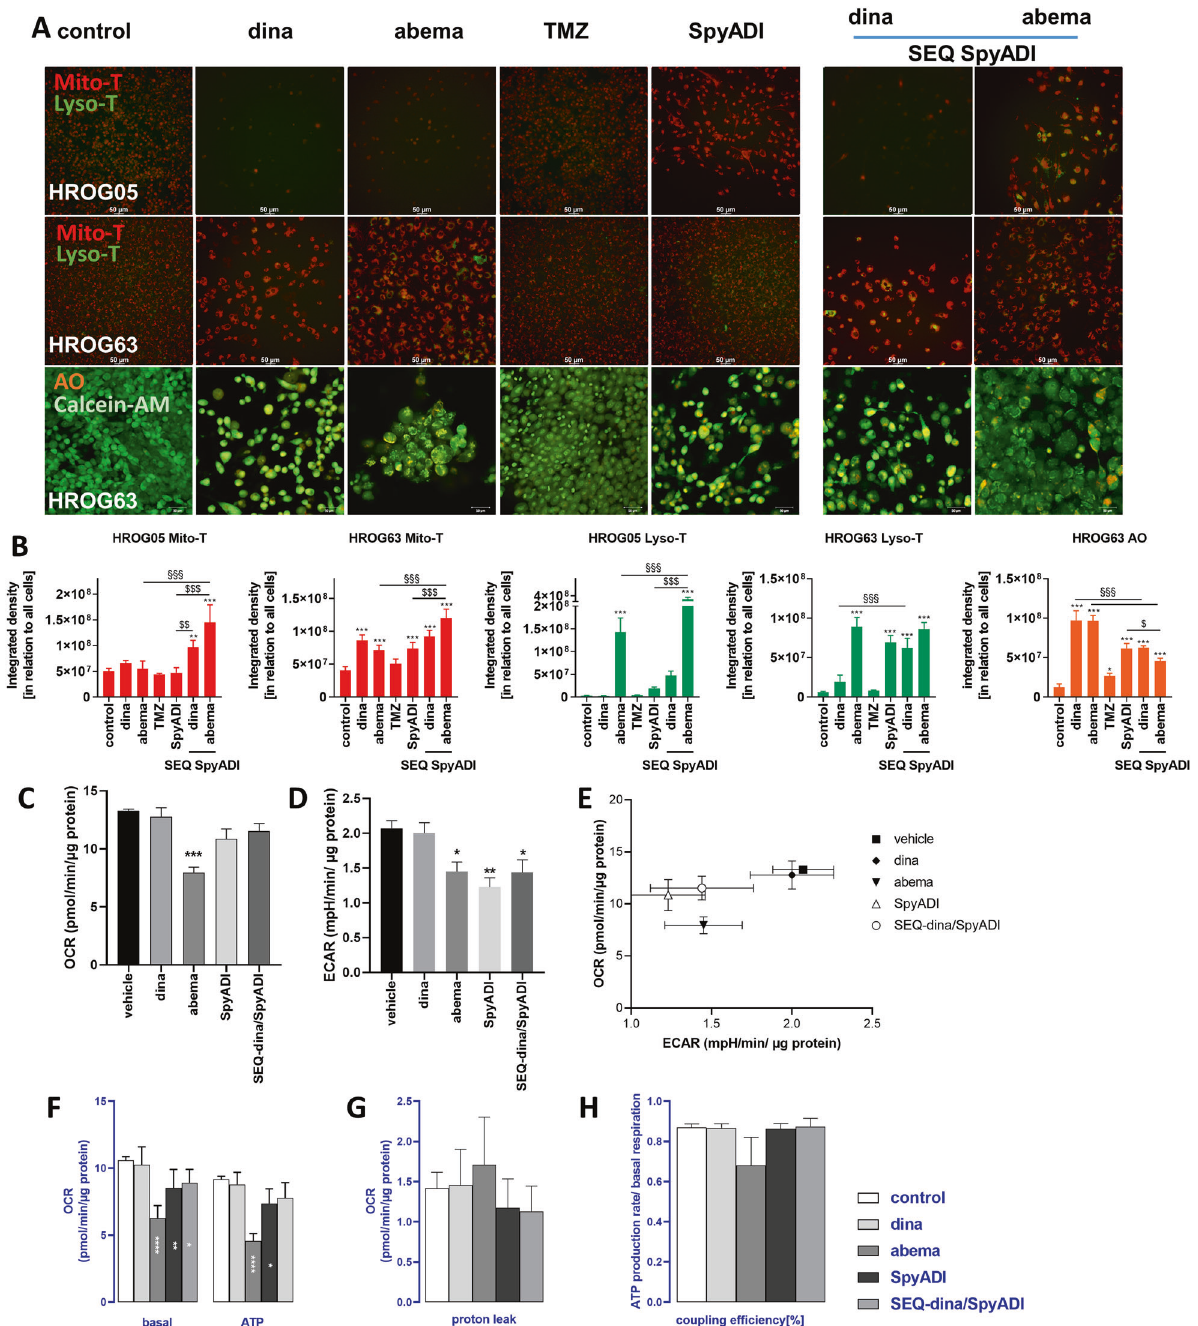
Fig. 4 In fl uence on mitochondria, lysosomes/autophagy, ER and extracellular fl ux analysis. A , B Mitochondrial function and/or acidic compartments (LysoTracker and Acridine orange (AO)) in 2D-cultured and treated GBM cells (HROG05, HROG63) was examined by immuno fl uorescence imaging as described in materials and methods (Mito- [red] and Lyso-Tracker [green]; Calcein AM [green] and Acridine orange [orange]). A Merged fl uorescence is presented (scale bar A : 50 μ m). CDKi-SpyADI impairs mitochondrial membrane potential (MMP) and SEQ-abemaciclib administration elevates LysoTracker and AO staining. B Quanti fi cation of Mito- and Lyso-Tracker as well as AO-positive cells using ImageJ software (integrated density analysis). n = 3 – 6 independent experiments; ** p < 0.01; *** p < 0.001; §§§ p < 0.001; $ p < 0.05; $$ p < 0.01; $$$ p < 0.001. One-way ANOVA. C – H The oxygen consumption rate (OCR) and extracellular acidi fi cation rate (ECAR) of treated HROG05 cells was recorded by a Seahorse XFe24 Analyzer ( C , D ). To determine the basal respiration (basal, E ), ATP-dependent respiration (ATP, F ), proton leak ( G ) and coupling ef fi ciency ( H ) mitochondrial stress test was applied with injection of 1.5 µM oligomycin (Port A), 1.0 µM FCCP (Port B) and 0.5 µM Antimycin A and Rotenon, each (Port C). Decreased OCR and ECAR after treatment with abemaciclib, SpyADI or SEQ dinaciclib/SpyADI were observed. Signi fi cant reduction of basal OCR and partially also of ATP-production-based OCR was shown, indicating dysfunctional mitochondria. n = 3 independent experiments; ∗ p < 0.05; ∗∗ p < 0.002; ∗∗∗ p < 0.0002; ∗∗∗∗ p < 0.0001. One-way ANOVA.